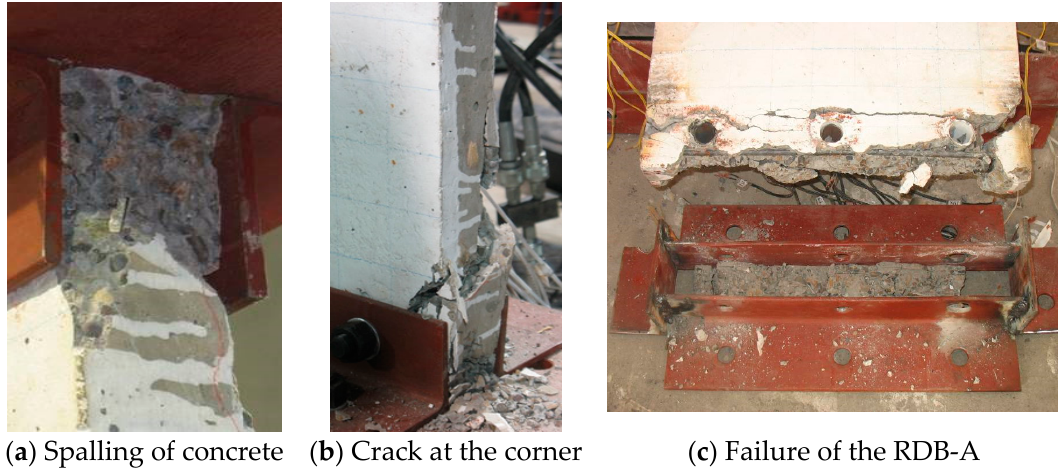
Figure 5. Failure modes of the RDB-A.